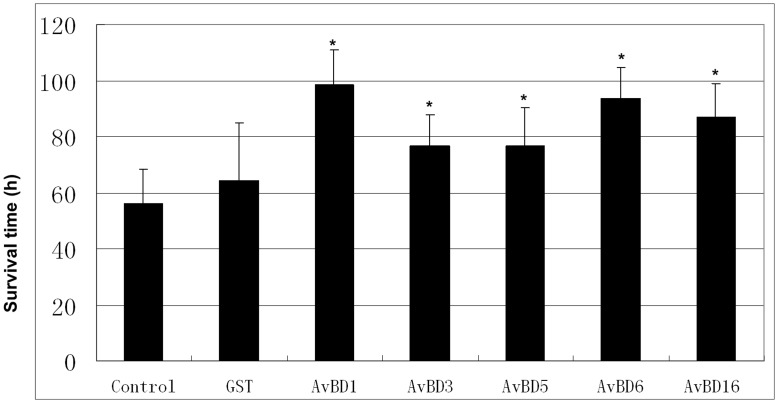
Antiviral activities of glutathione-S-transferase (GST), and recombinant Apl_avian β-defensins (rApl_AvBDs) against duck hepatitis virus.All assays were performed in three independent experiments, with five replicates per experiment, and each bar represents the mean ± SD. The data were analyzed using SAS [24], and P<0.05 is indicated by an asterisk “*”.